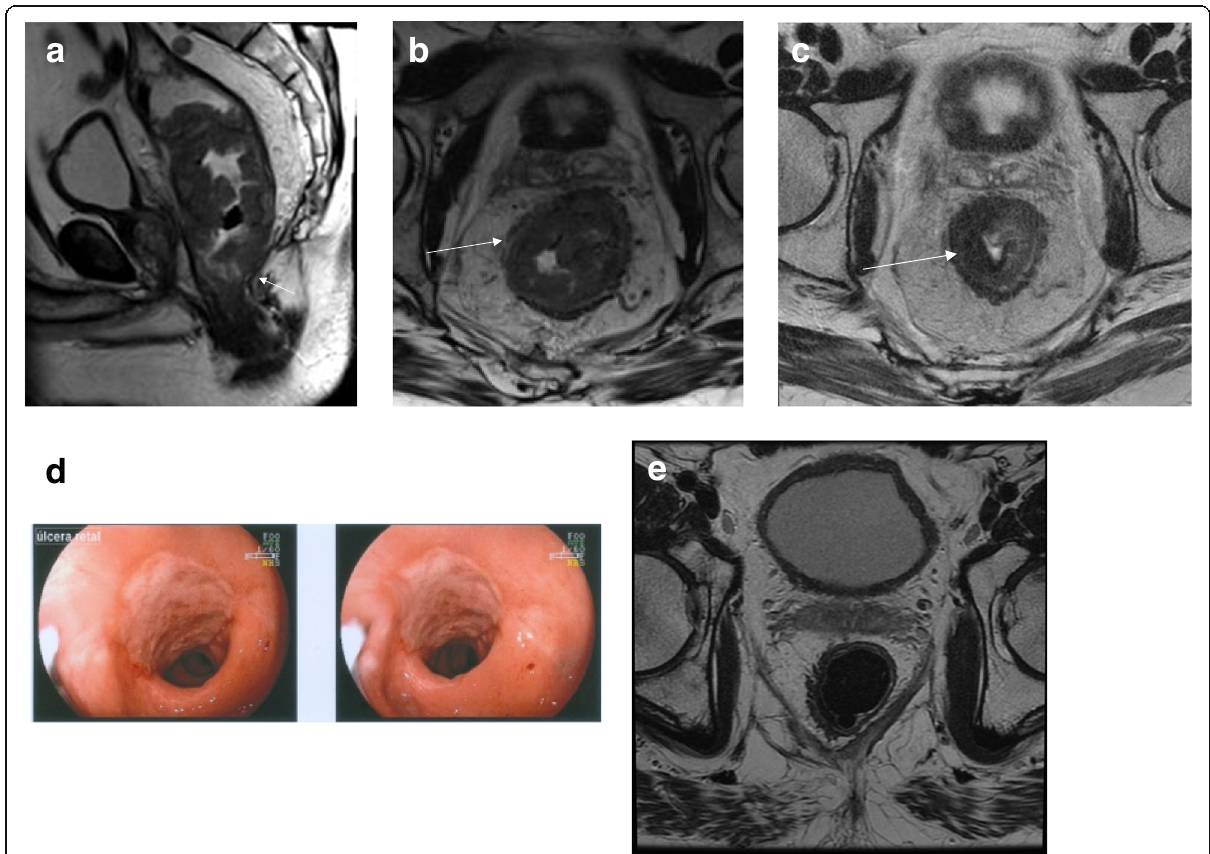
Fig. 12 Long-time intervals of reassessment. a Sagittal T2WI shows the baseline staging of a low rectal tumor with the distal margin lying below the intersphincteric plane (arrow). b Axial T2WI shows the semiannular lesion (arrow). c Restaging after 10 weeks showed a good response with predominant low-signal intensity within the lesion (arrow). d Proctoscopy showing good but incomplete response with residual ulceration. e Reassessment after longer intervals showed evidence of ongoing response to CRT. Follow-up exams after 22 weeks revealed findings consistent with complete clinical